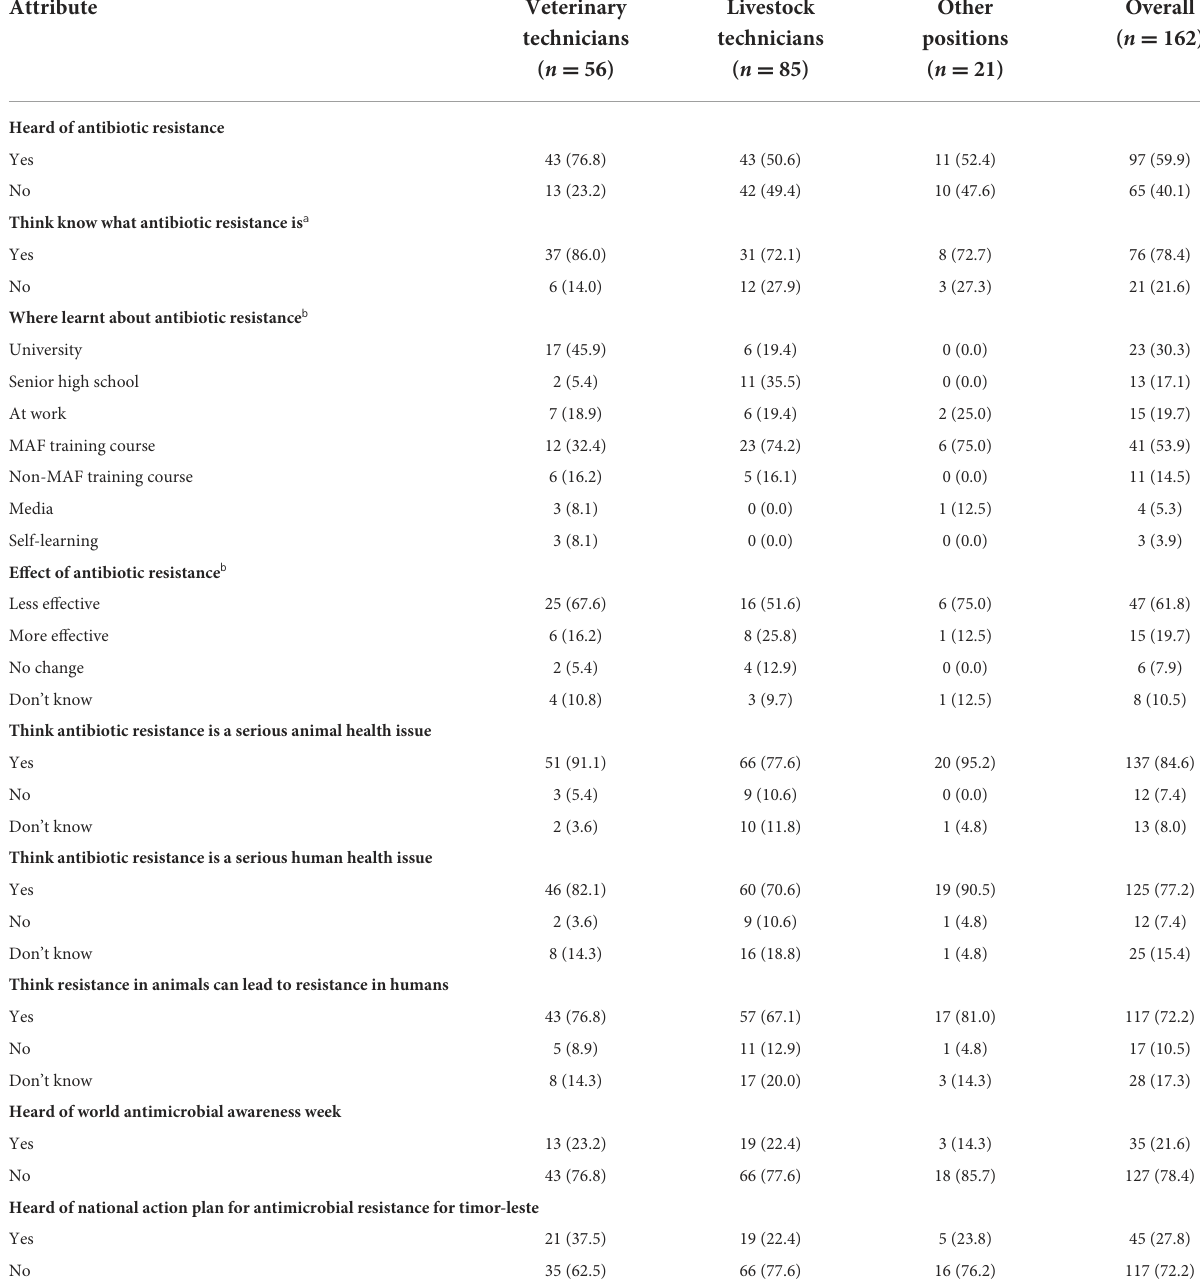
TABLE 3 Knowledge of antibiotic resistance (overall and by position) of government animal health workers. Attribute Veterinary